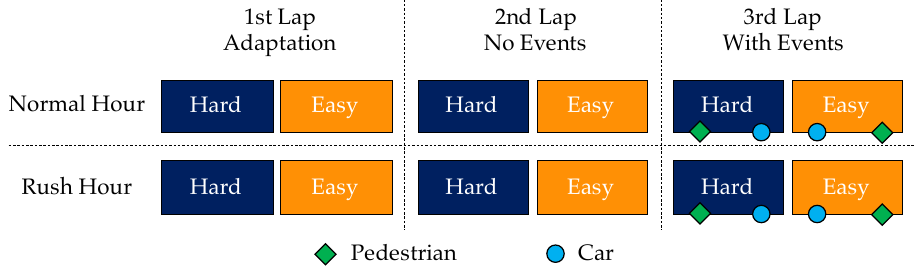
Figure 1. Summary of the experimental protocol. The experiment was carried out with two driving tasks which were different in terms of traffic (Normal and Rush hour) and performed in a randomized order. Each of the driving tasks were comprised of three laps: The 1st lap was intended to make the driver habituated to the circuit and the other (2nd and 3rd) laps were used for analysis. Moreover, events were introduced in the 3rd lap to assess the presence of different scenarios on road when there are absent and present